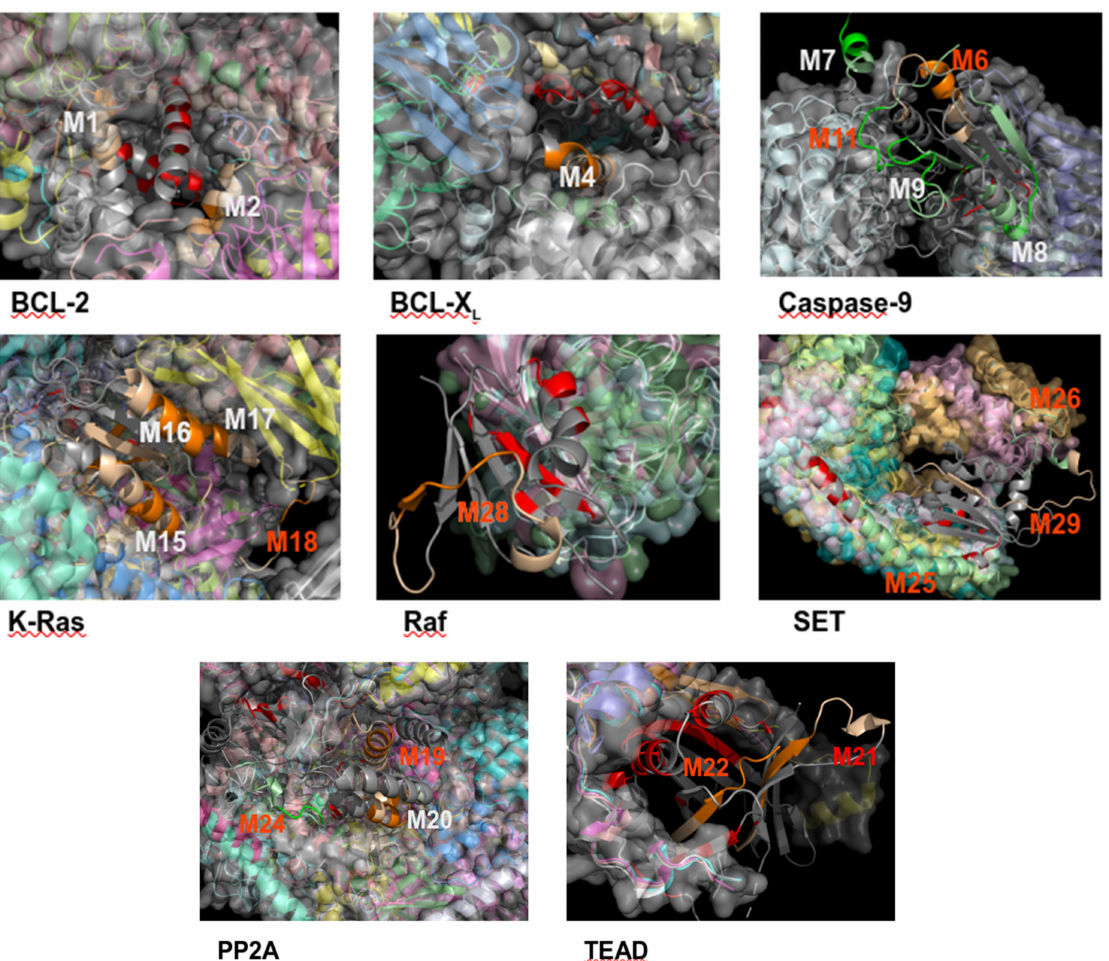
Figure 3. 3D illustration of the surroundings of the IPs when not frequently located at the protein–protein interface. Red labels correspond to IPs showing some biological